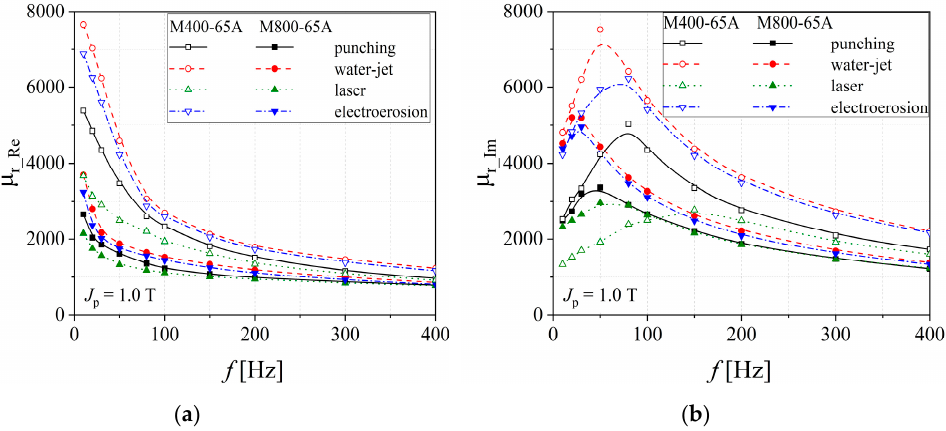
Figure 8. Real ( a ) and imaginary ( b ) components of relative magnetic permeability versus frequency measured at J p = 1.0 T, in the case of M800-65A and M400-65A electrical steels.